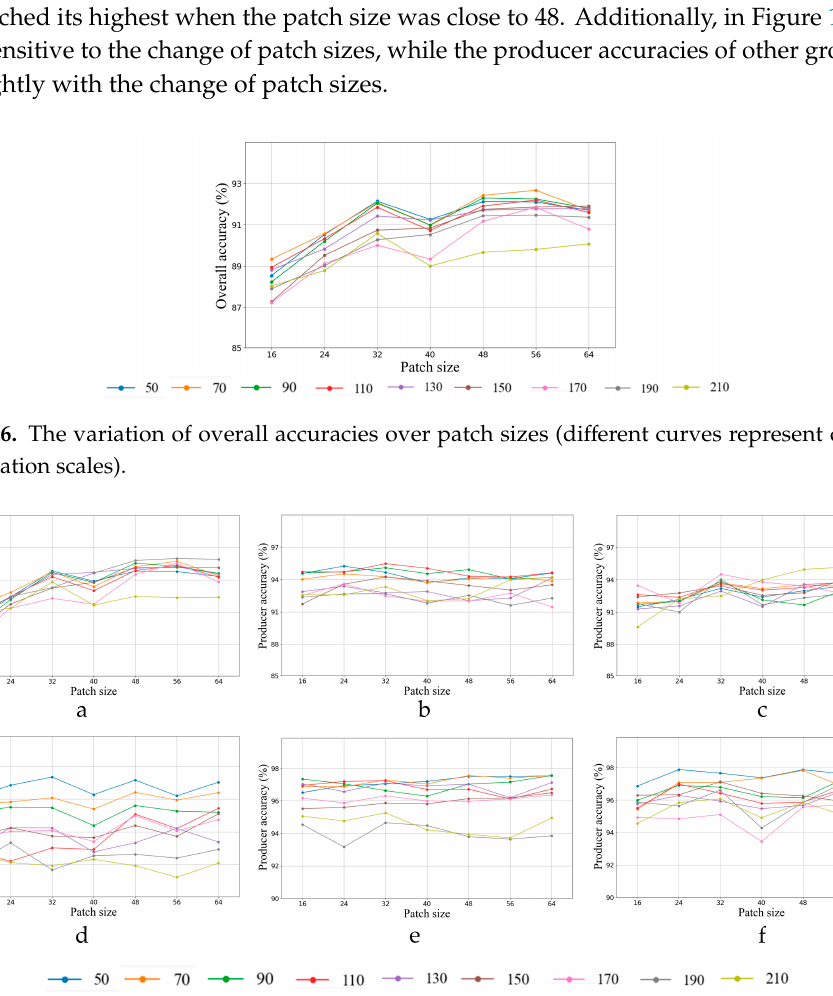
Figure 17. The variation of producer accuracies of Buildings ( a ), Vegetation ( b ), Roads ( c ), Water ( d ), Shadows ( e ) and Bare soils ( f ) over patch sizes (the horizontal axis refers to patch size, the vertical axis refers to accuracies, while di ff erent curves represent di ff erent segmentation